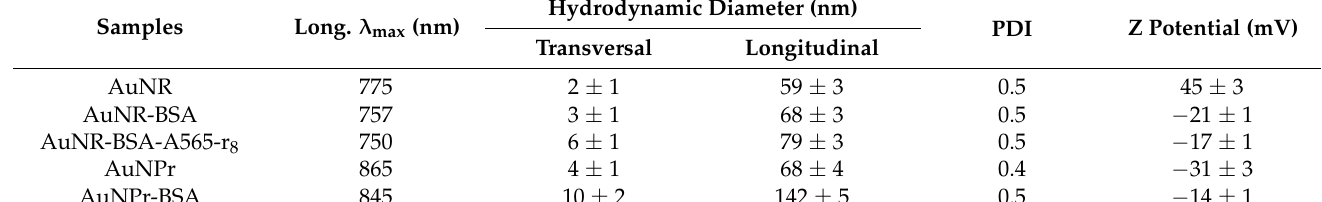
Table 1. Physicochemical parameters of the synthesized nanoparticles and nanoconstructs.